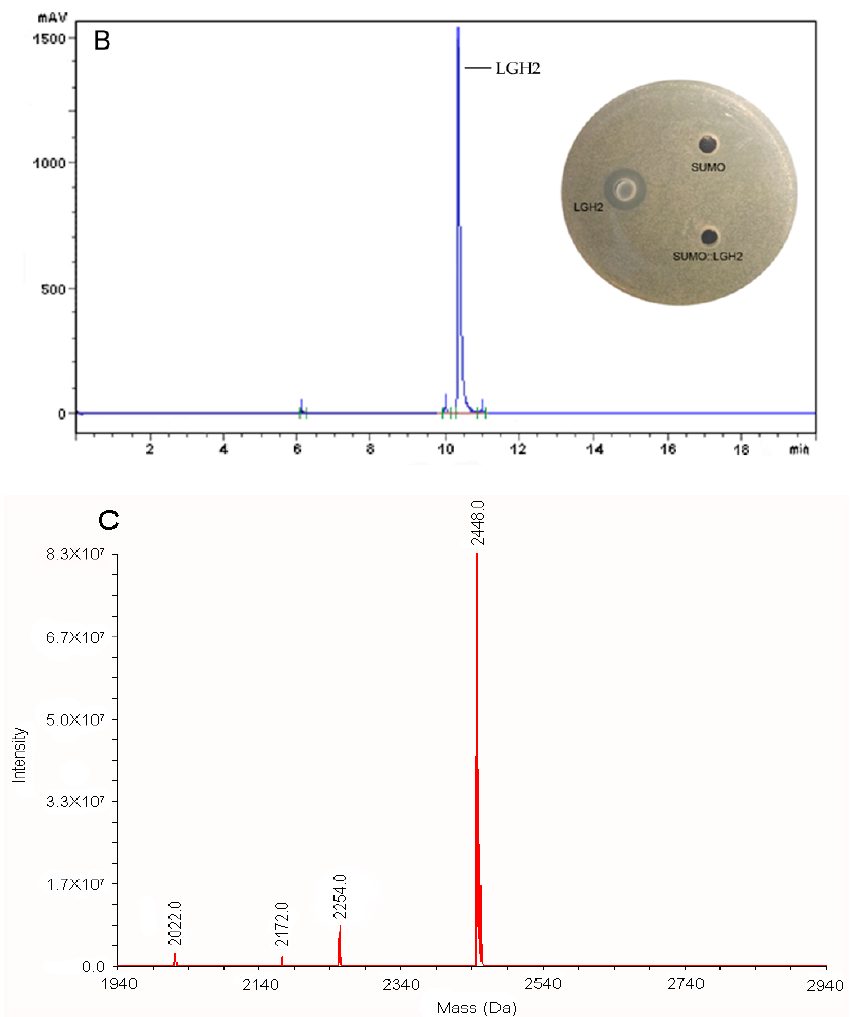
Figure 5. Purification and identification of LGH2. ( A ) Purification of hydrolysate by RP-HPLC. ( B ) Identification of purified peptide by RP-HPLC. The indictor strain was S. aureus ATCC 29213. ( C ) MALDI-TOF MS analysis of the purified LGH2.